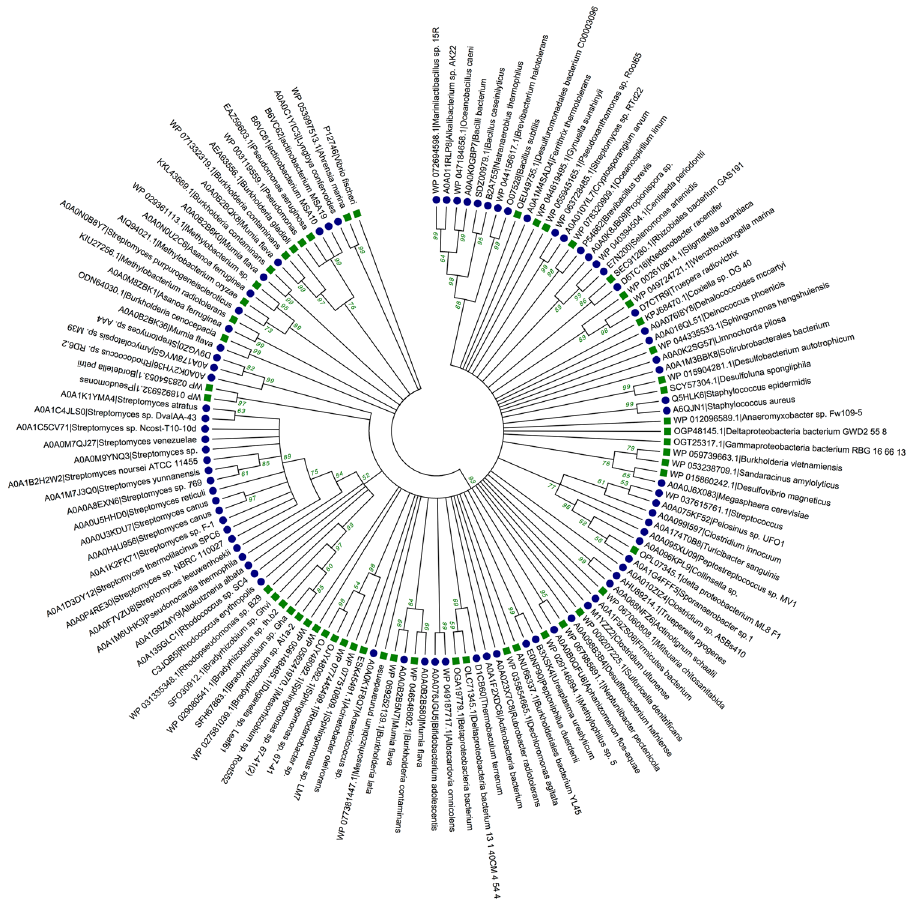
Figure 5. Phylogenetic tree reconstruction of LuxR containing protein employing Maximum Likelihood method on Gram-positive bacteria and their respective BLAST hits [ Gram-positive bacteria ( ), and Gram- negative bacteria (